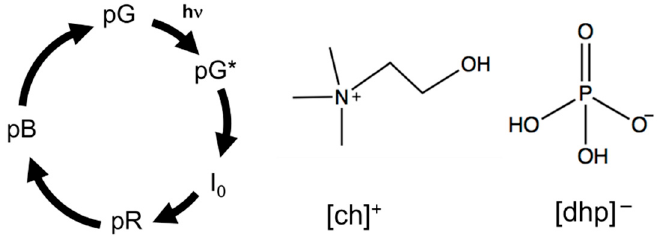
Figure 1. Simplified PYP photocycle model and chemical structure of [ch][dhp].